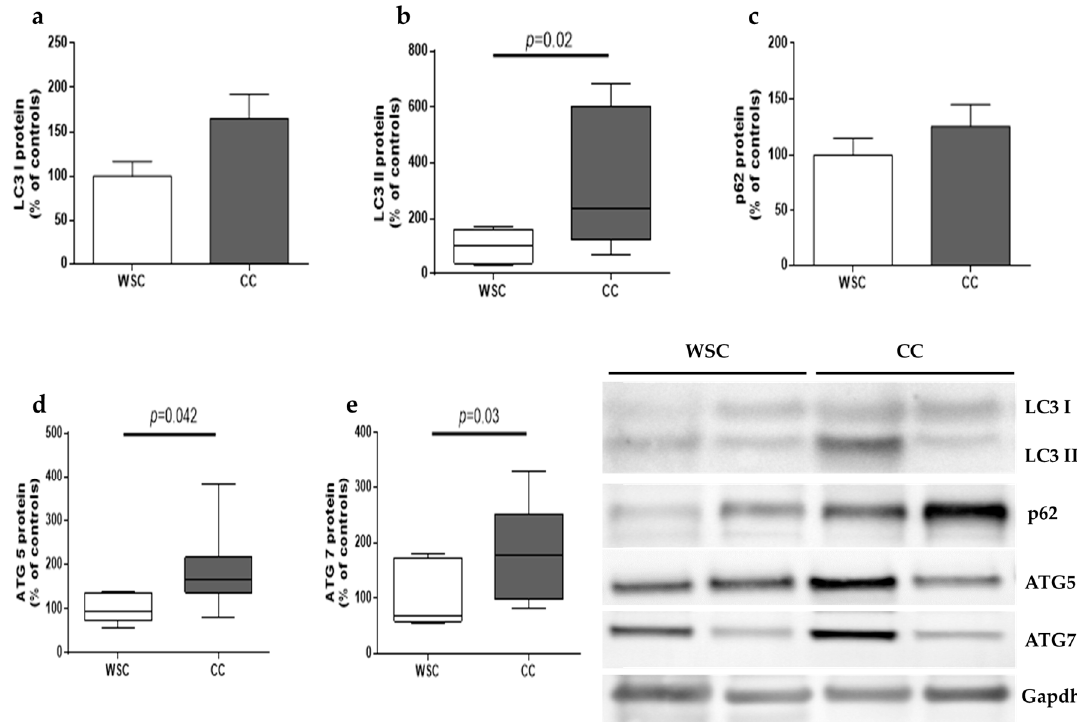
Figure 3. Autophagy-related proteins in skeletal muscle of WSC and CC patients. Western blot analysis of ( a ) LCB3 I (WSC, n = 8; CC, n = 10); ( b ) LC3B II (WSC, n = 8; CC, n = 10); ( c ) p62 (WSC, n = 8; CC, n = 10); ( d ) ATG5 (WSC, n = 6; CC, n = 8) and ( e ) ATG7 (WSC, n = 6; CC, n = 8). Data are expressed as mean and standard error and were compared using Student’s t test or were represented in box plots and compared using Mann–Whitney test. WSC—weight-stable cancer patients; CC—cachectic cancer